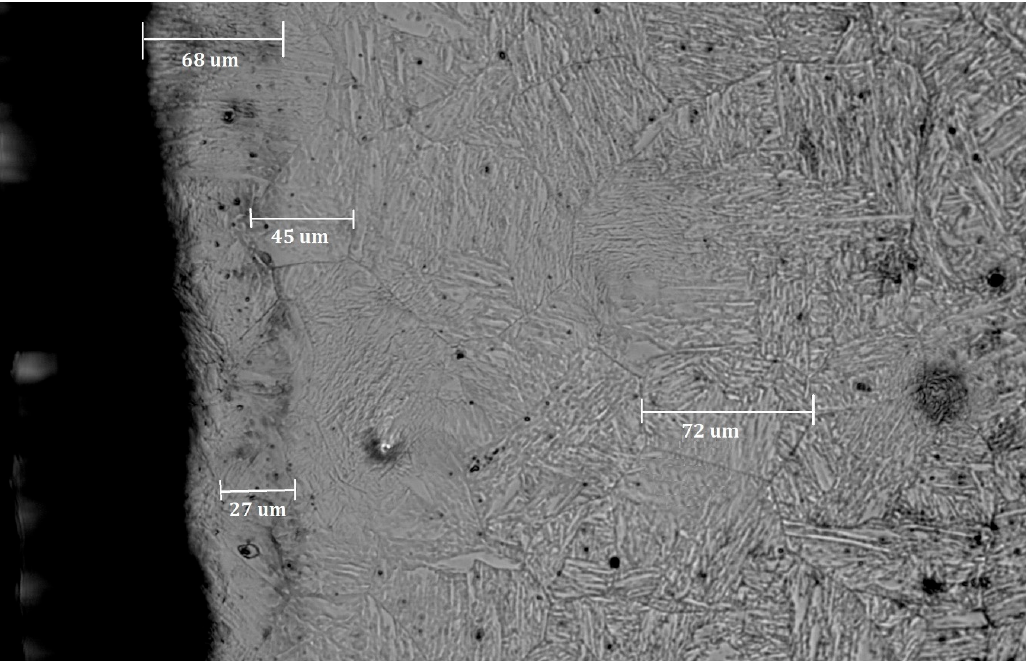
Figure 7. View of the microstructure of the seventh cross-section, on the inner side of the blade with marked representative dimensions (grain size and depth of the plasticized layer). Materials 2020 , 13 , x FOR PEER REVIEW